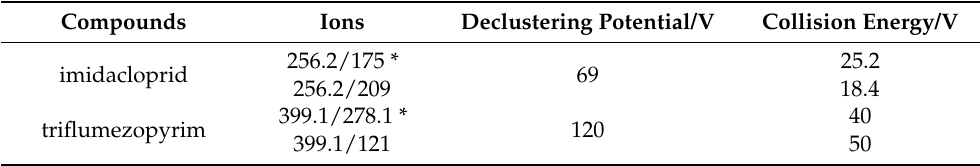
Table 6. MS/MS parameters for the